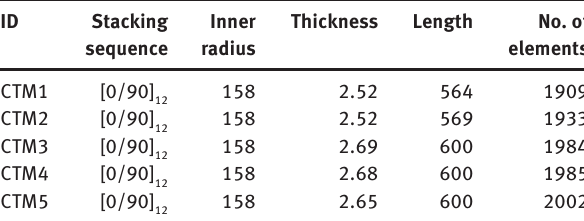
Table 2: Dimensions (in millimiters) of the composite